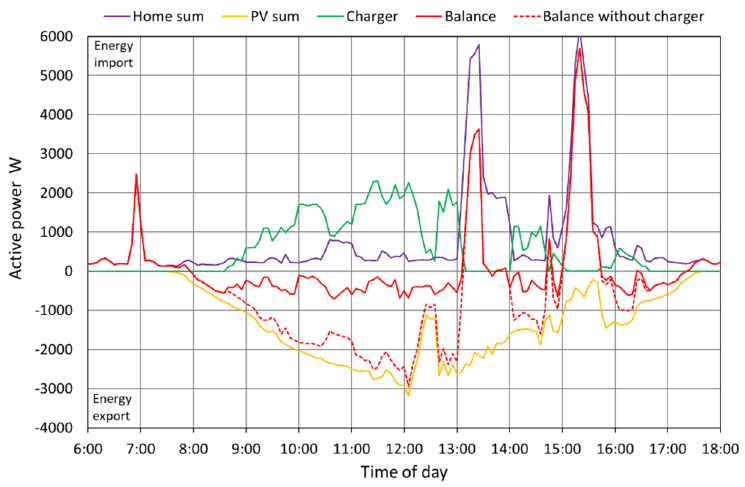
Figure 2. Energy flows during sun operation on 24 October 2021.